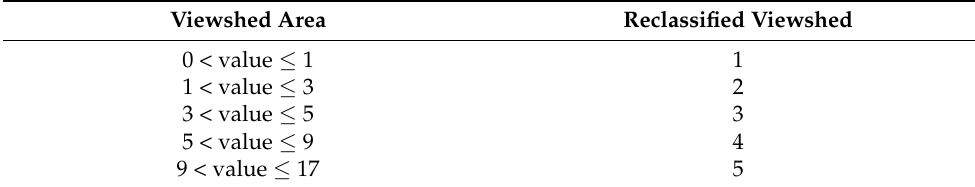
Table 11. Reclassification of the landscape component. Viewshed